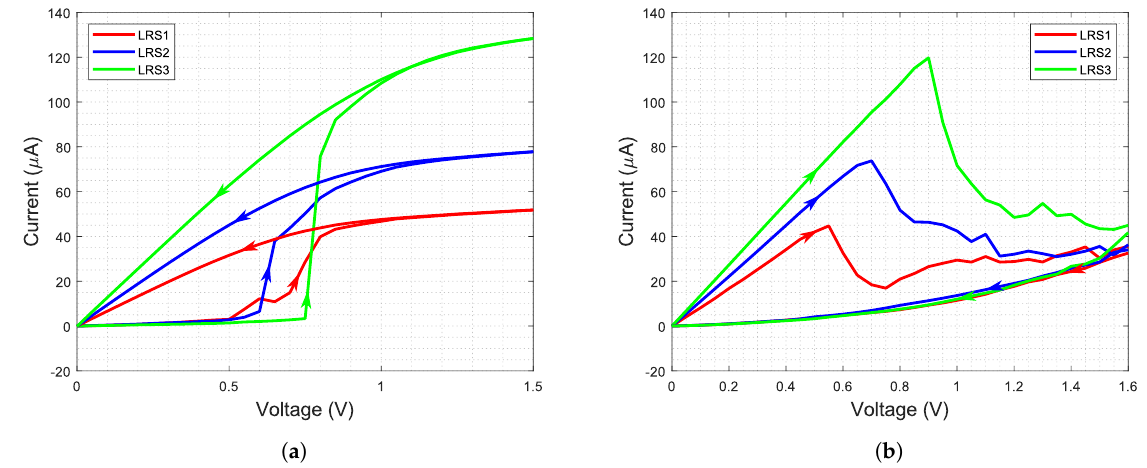
Figure 3. I-V curves of programming the IHP RRAM cells: ( a ) Set. ( b ) Reset. Table 1. RRAM cell